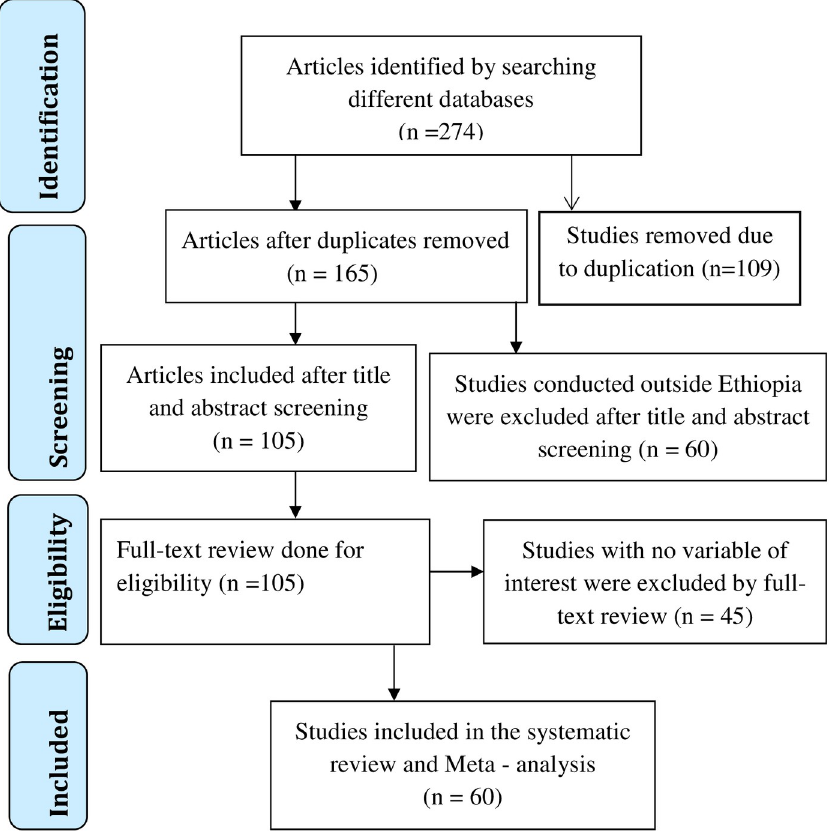
Fig 1. Flow chart on the article selection strategy for systematic review and meta-analysis of prevalence and predictors anemia among pregnant women in Ethiopia, 2021.